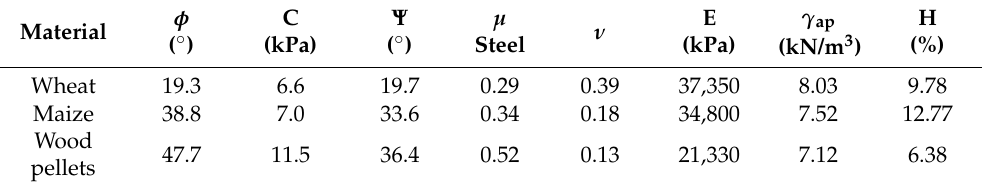
Table 9. Recommended values for the different mechanical properties of the tested